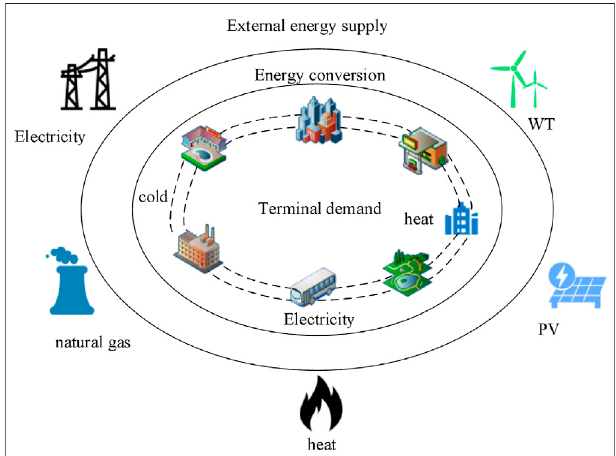
FIGURE 2 | The structure of the energy